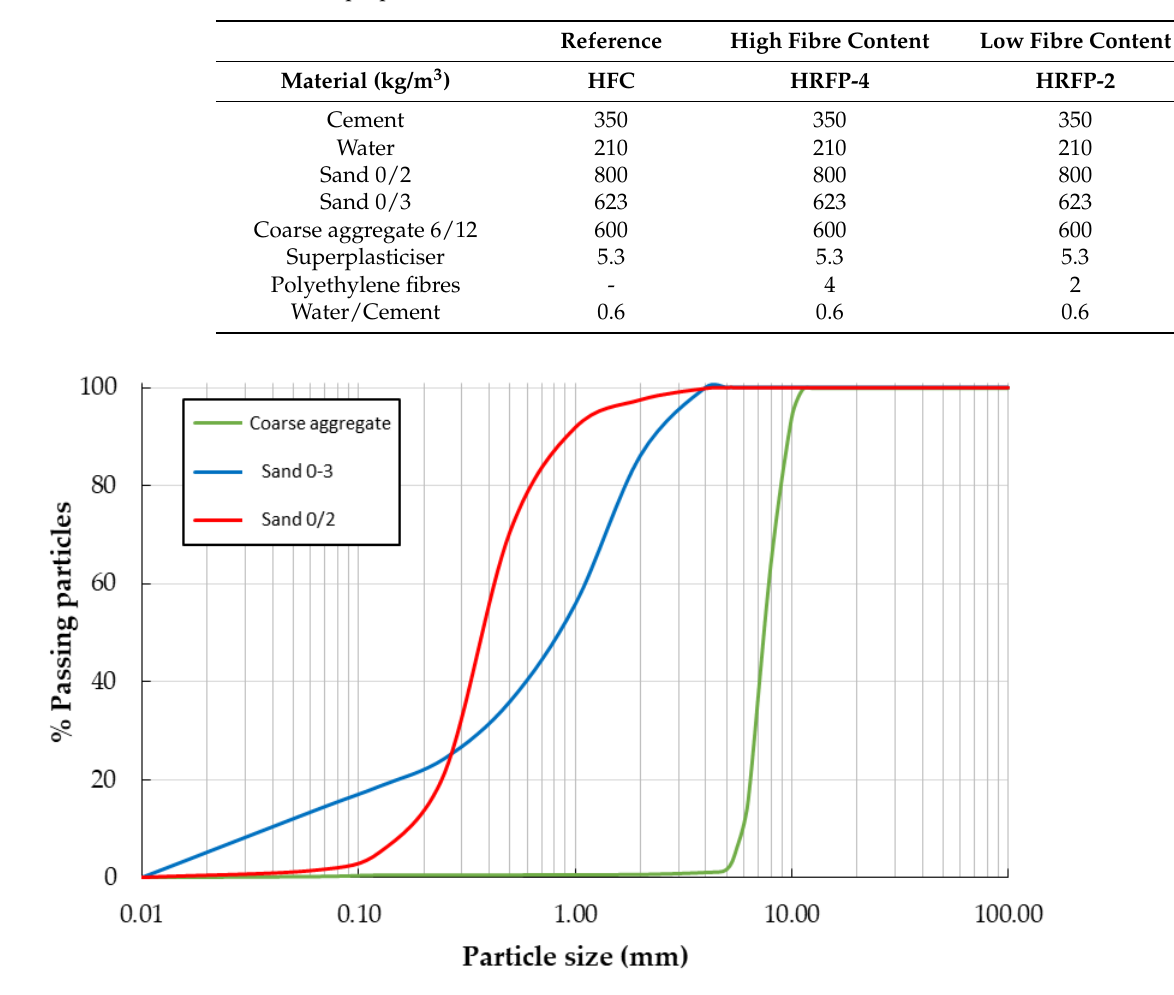
Figure 5. Grading Figure 5. Grading curve.